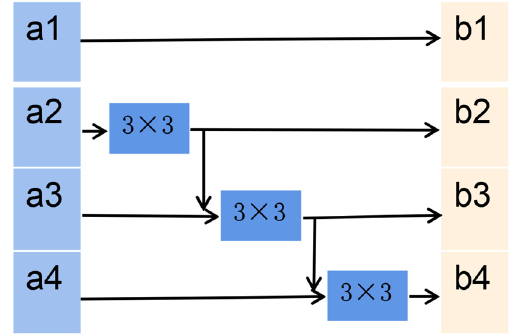
Figure 3. Res2Net module structure diagram.